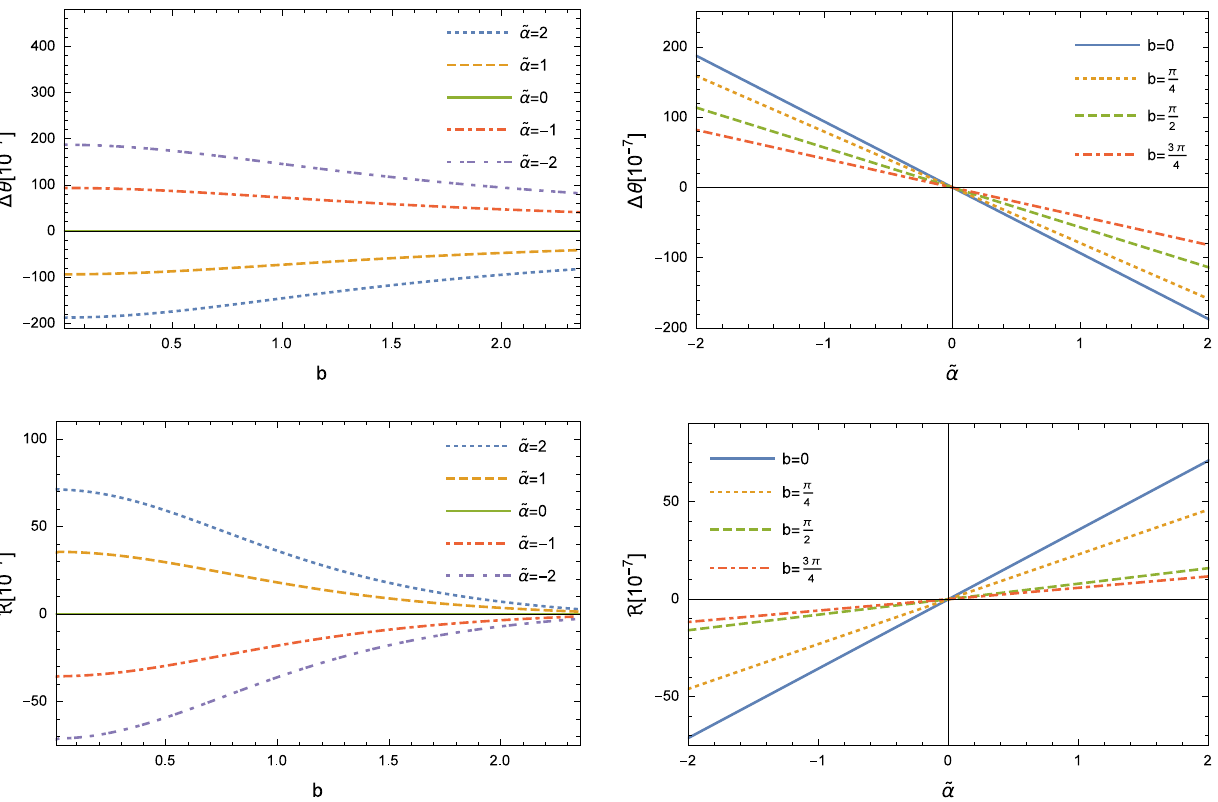
Fig. 5 Variation of the difference of angular image position (cid:15)θ (the top two panels) and relative magnitude R (the bottom two panels) between PPL and PPM with phantom hair b and coupling constant (cid:12) α in the regular phantom black hole. The angular is expressed in μ arc